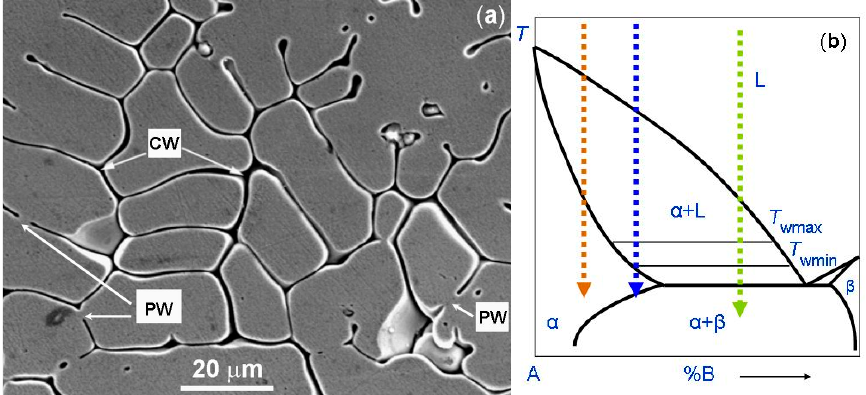
Figure 4. ( a ) SEM micrograph of the plasma cladded CoCrCuFeNi HEA coating. Arrows with the symbol CW show the completely wetted GBs. Arrows with the symbol PW show the partially wetted GBs. ( b ) Schematic of the binary diagram for 3D bulk phases for the explanation of respective GB wetting phenomena. The dotted red arrow shows the cooling trajectory corresponding to the micrographs for the CoCrCuFeNi HEA coating ( a ). The dotted blue arrow shows the cooling trajectory corresponding to the micrograph for the CoCrFeNiMn HEA coatings. The dotted green arrow shows the cooling trajectory corresponding to the micrograph for the CoCrCuFeNiNb HEA coating. Micrograph 4a is reprinted with permission from ref. [84]. Copyright 2014